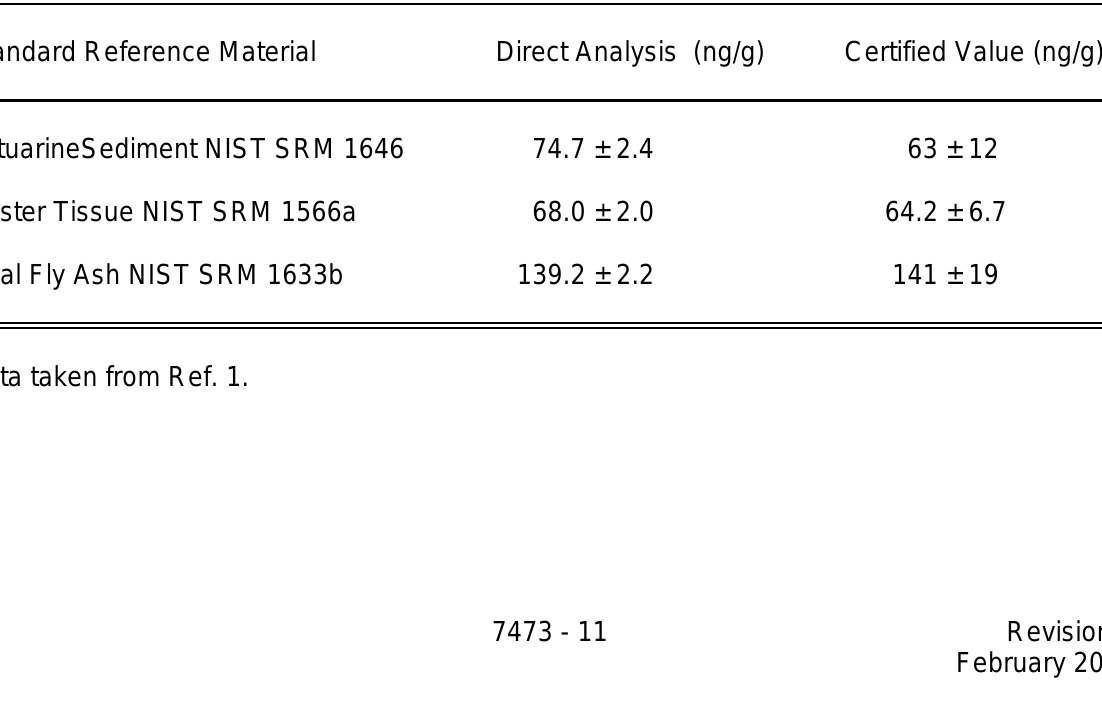
EXAMPLE FIELD ANALYSIS RESULTS (MEAN ± 95% CONFIDENCE INTERVAL) OF DIRECT ANALYSES OF VARIOUS NIST SRMs USING THE DMA 80 (MILESTONE,